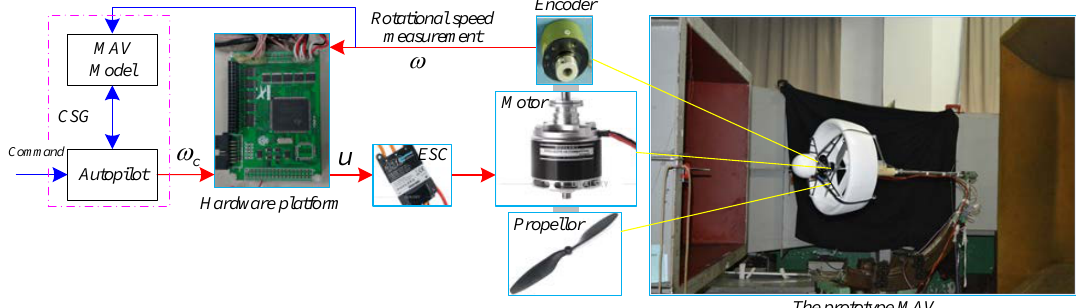
Figure 4. The hardware-in-loop (HIL) experimental setup.